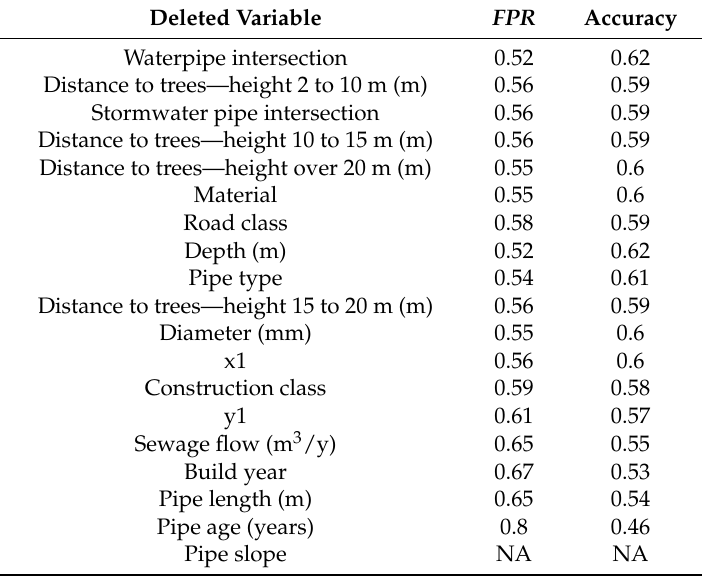
Table 5. Results of the analysis on a reduced set of predictor